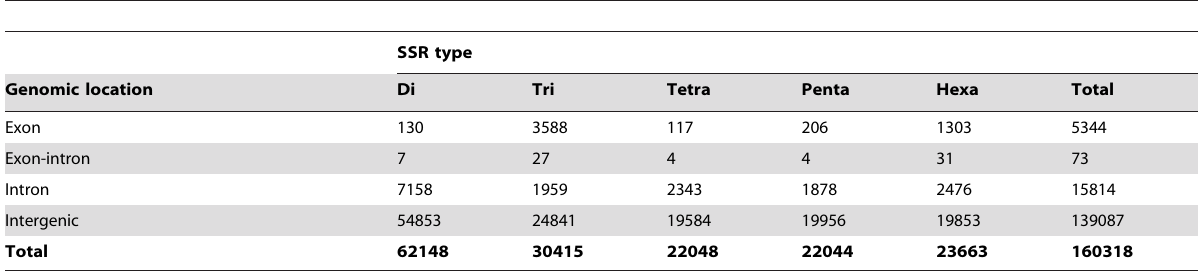
Table 1. Number of simple sequence repeats by genomic